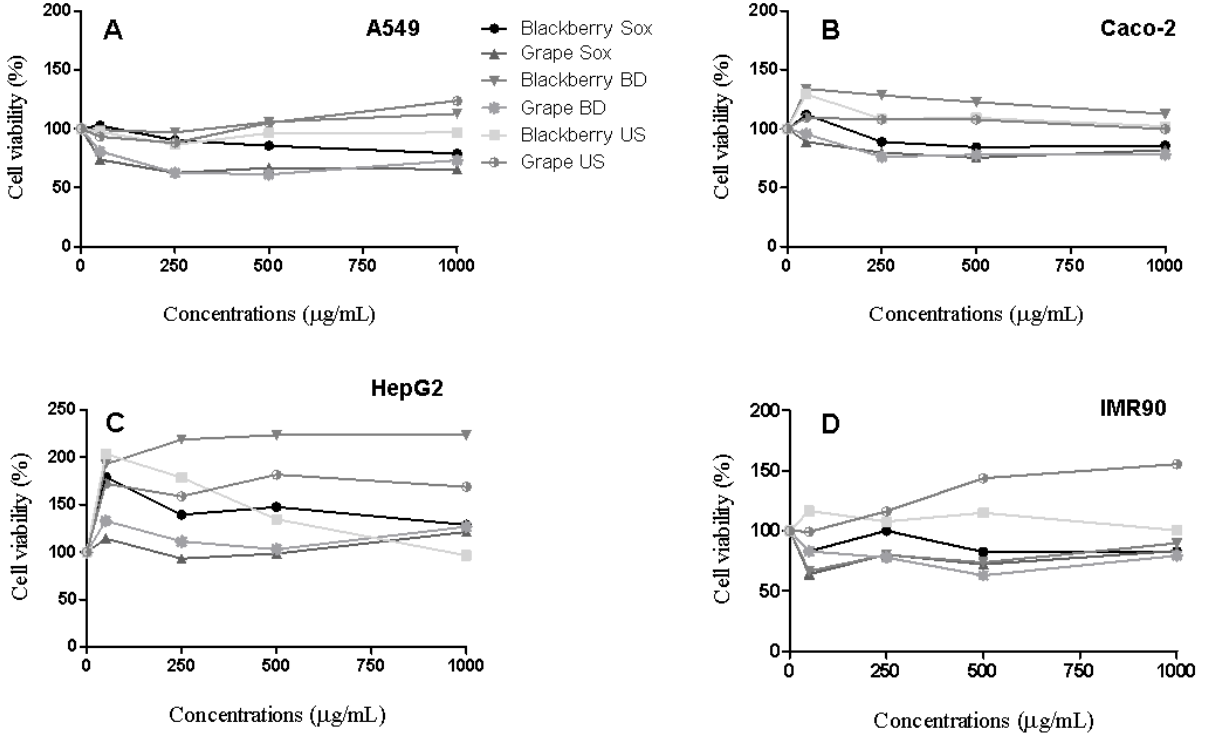
Figure 1. Representative cell viability of A549 ( A ) Caco-2 ( B ), HepG2 ( C ), and IMR90 ( D ) cells after 48 h exposure to non- polar blackberry and grape seed